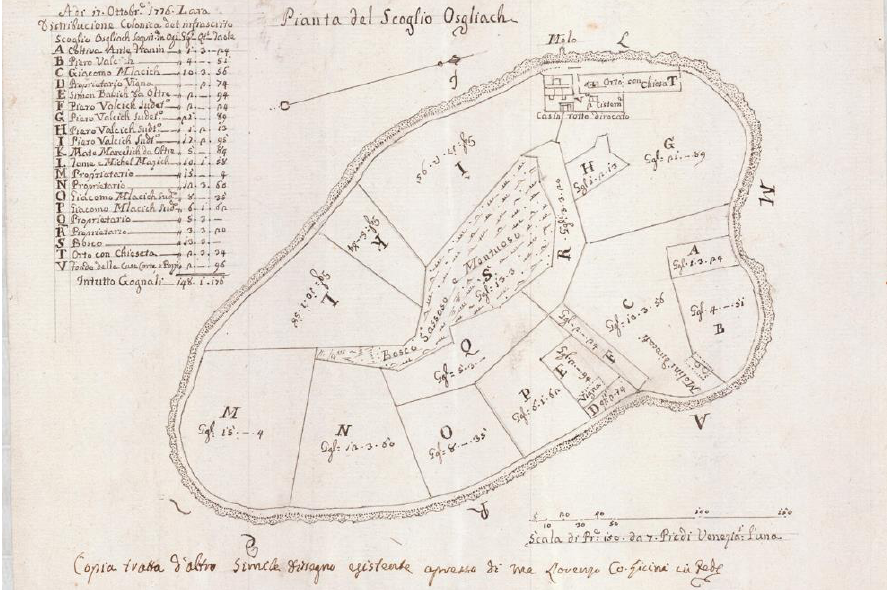
Figure 4. Plan of Ošljak (Pianta del Scoglio Osgliach) made on 17 October, 1776.